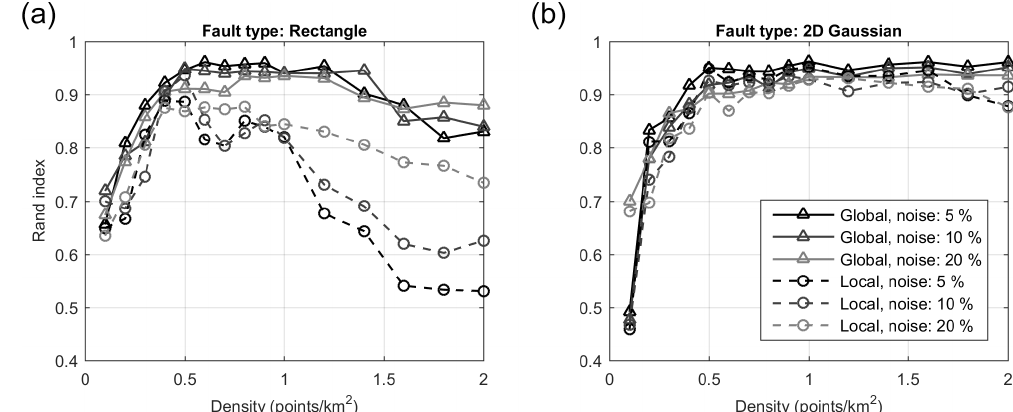
Figure 5. Clustering similarities between ground truth synthetic dataset and method results quantified by the Rand index. Global and local merging criteria are shown as solid and dashed lines respectively. Background noise amplitude is shown as shades of gray. Results for ground truth sampled from (a) rectangular fault planes and (b) elliptic Gaussian kernels with similar